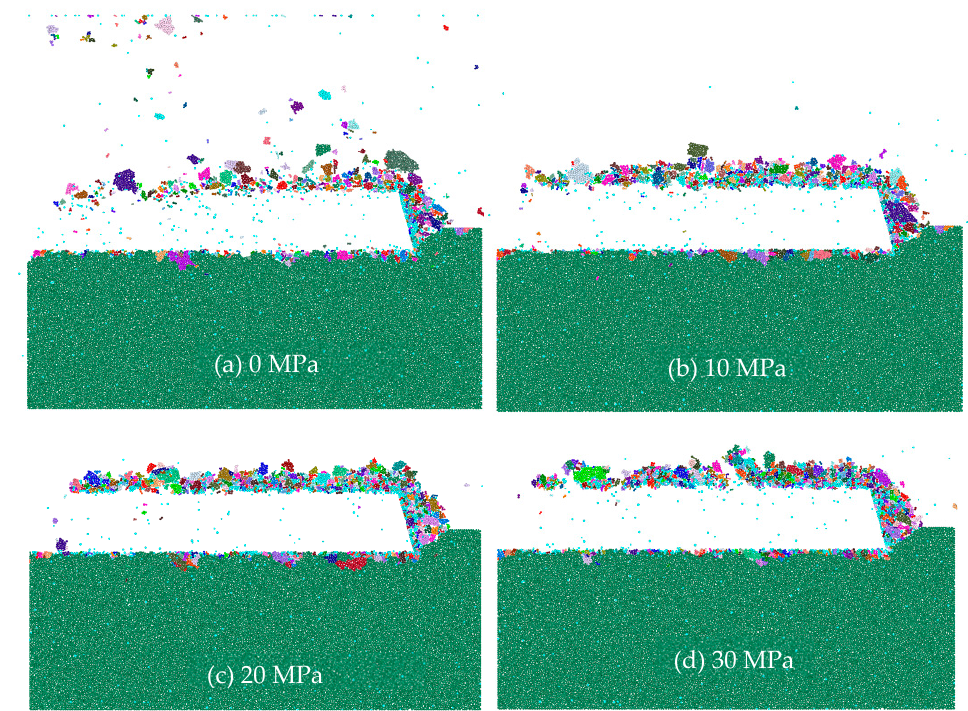
Figure 17. Chip morphology under different ambient pressures.